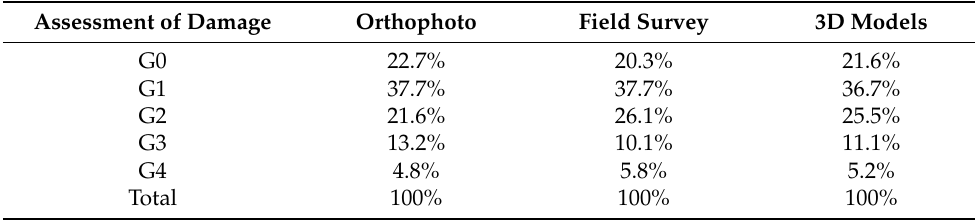
Table 4. Comparison of the results of the 2D and 3D assessment ratio and field survey.